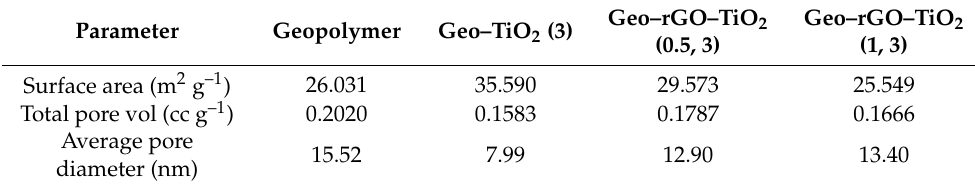
Table 5. BET parameters for pervaporation membrane